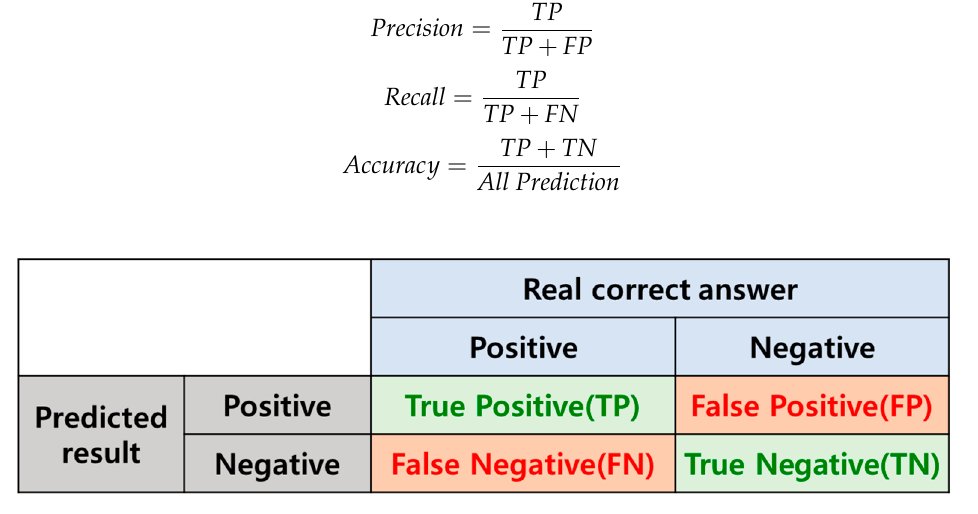
Figure 13. Confusion matrix.